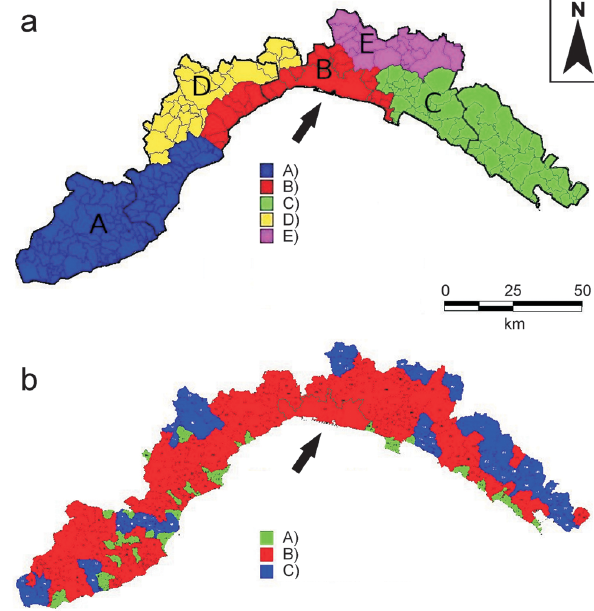
Fig. 11. (a) Meteo-hydrological alert zones map in Liguria: (A) Tyrrhenian catchments of western Liguria; (B) Tyrrhenian catchments of central Liguria; (C) Tyrrhenian catchments of eastern Liguria; (D) Adriatic catchments of western Liguria; (E) Adriatic catchments of eastern Liguria. (b) Municipal hydrological map in Liguria: (A) Ist category municipalities; (B) IInd category munic- ipalities; (C) IIIrd category municipalities (modified from Regione Liguria,